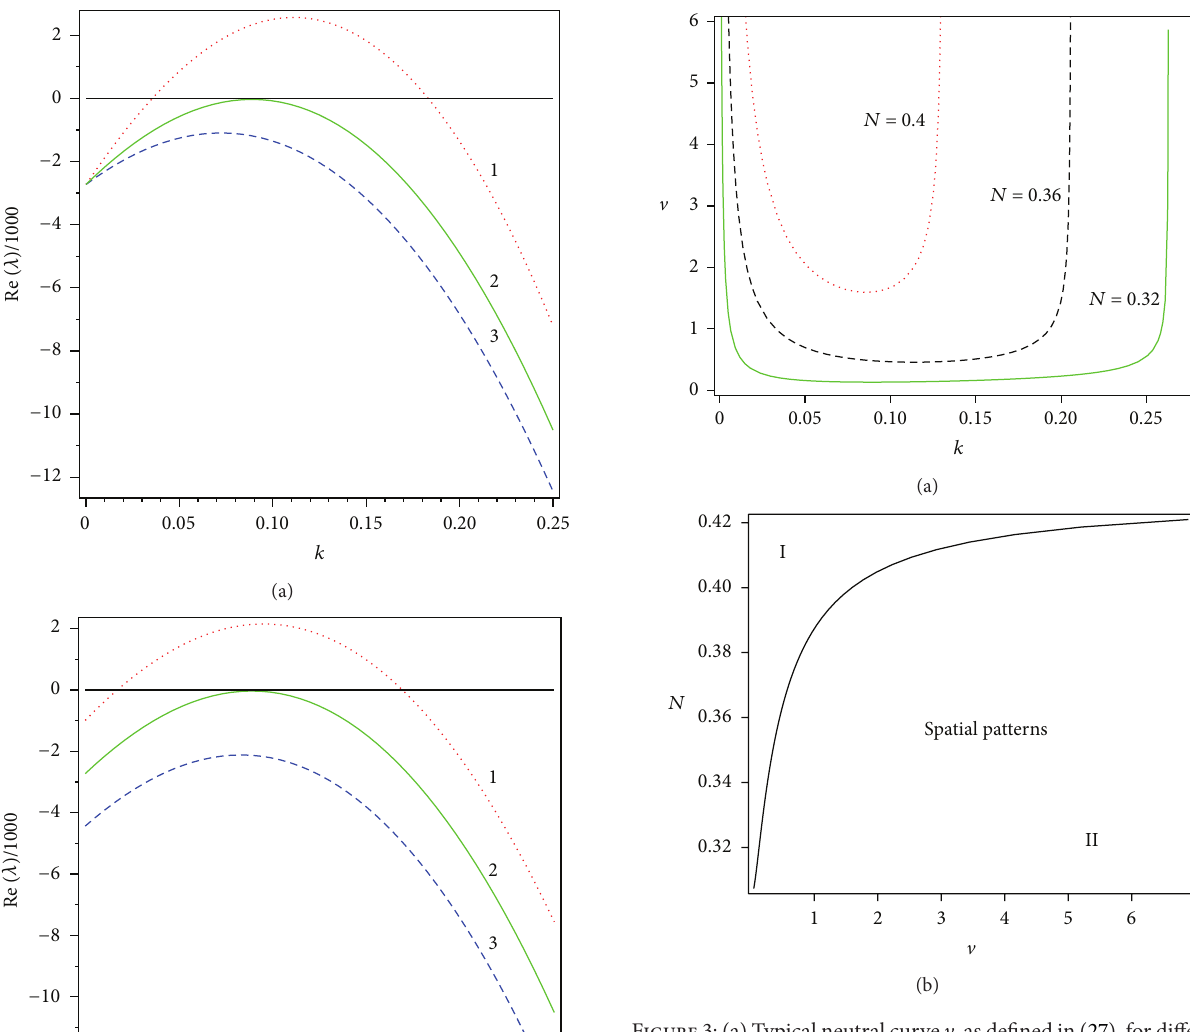
Figure 3: (a) Typical neutral curve V , as defined in (27), for different valuesof 𝑁 .(b)Numericalcalculationofstabilityinthe ( V , 𝑁) space. The curve can be obtained from the combination of (25) and